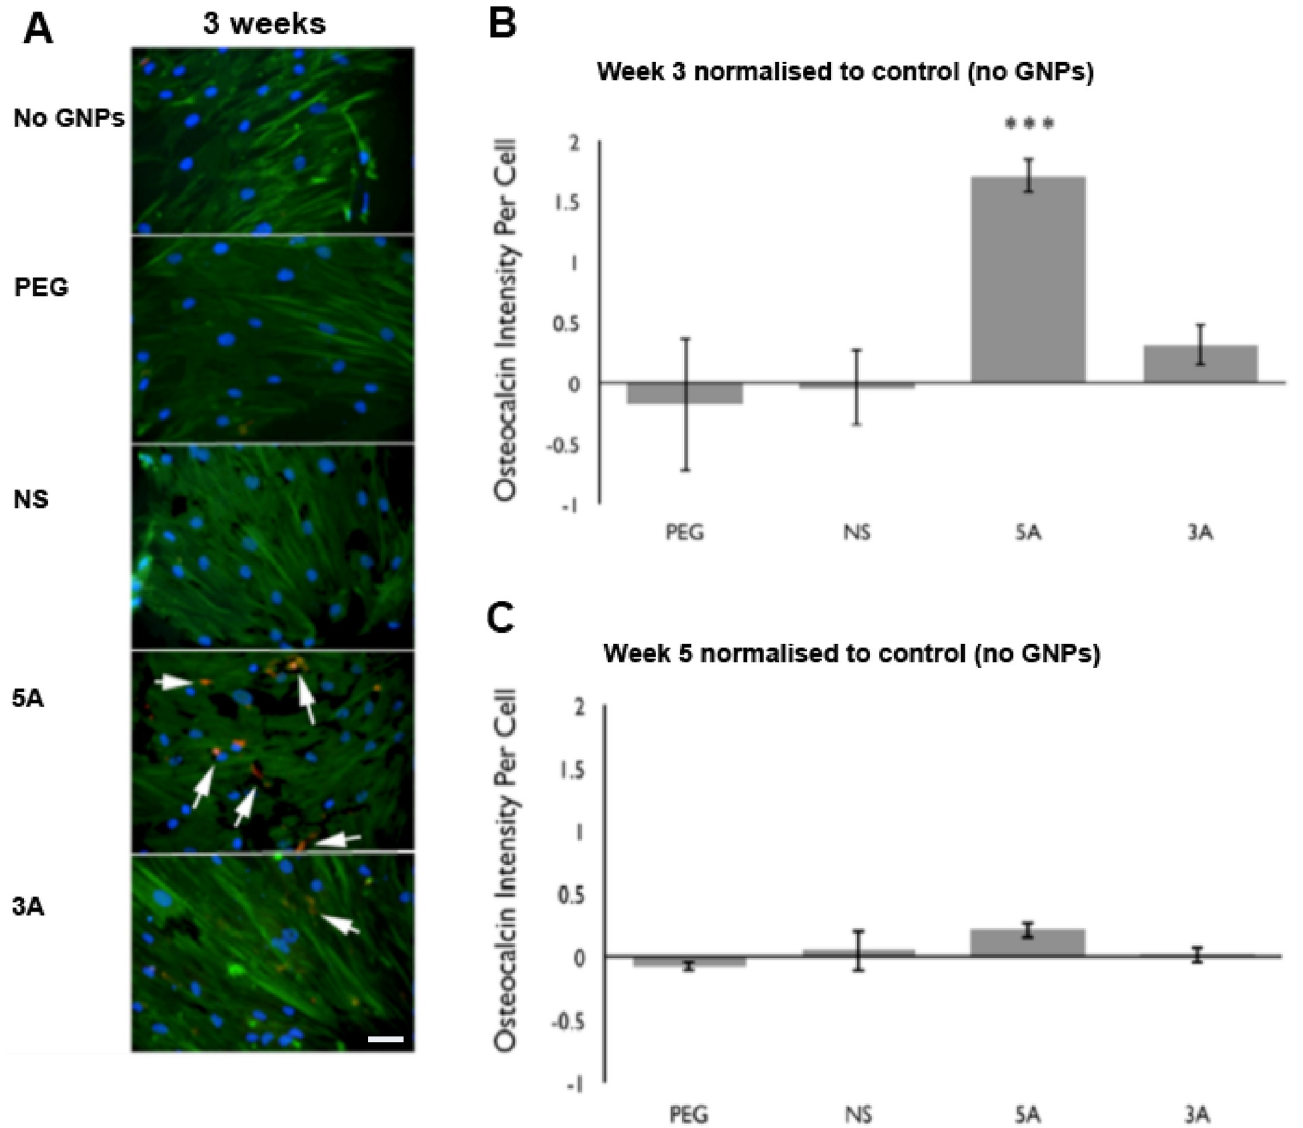
Fig 7. Osteocalcin nodule formation in MSCs. (A) Representative MSC images from GNP treatment after 3 weeks. Staining indicates actin (green), nucleus (blue) and osteocalcin nodules (red). Scale bar = 5μm (white arrows highlights osteocalcin staining). (B&C) Semi-quantification of osteocalcin staining in MSCs after treatment with GNPs for 3 and 5 weeks (B and C respectively). All treatments have been normalised to control cells treated with no GNPs. (n = 3, error bars denote SEM (cid:3)(cid:3)(cid:3) = p < 0.001).